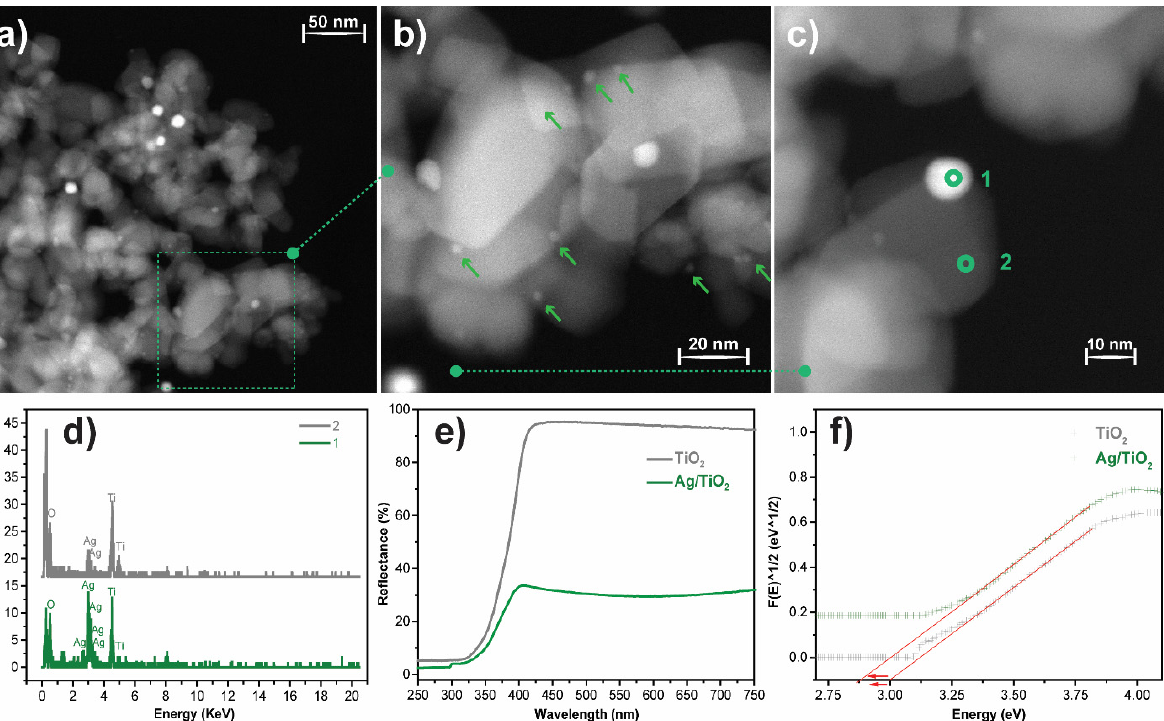
Figure 3. ( a – c ) STEM-HAADF-EDX images of Ag@TiO 2 nanocomposites with different amplifications, indicating the different measured regions: (1) Ag and (2) TiO 2 ; ( d ) EDX spectra with elemental identification of regions (1) and (2); ( e ) UV-Vis reflectance spectra of pure TiO 2 and Ag@TiO 2 ; ( f ) estimation of the bandgap for TiO 2 and Ag@TiO 2 samples at [F (R)]1/2 = 0.